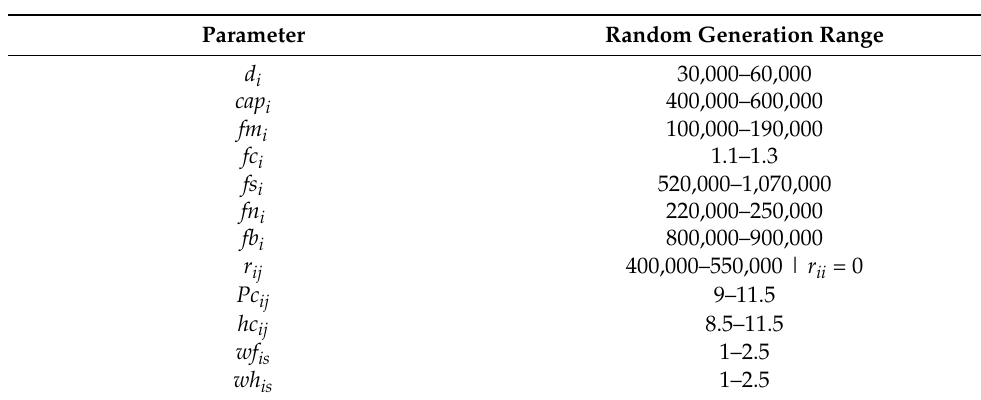
Table A2. Parameter